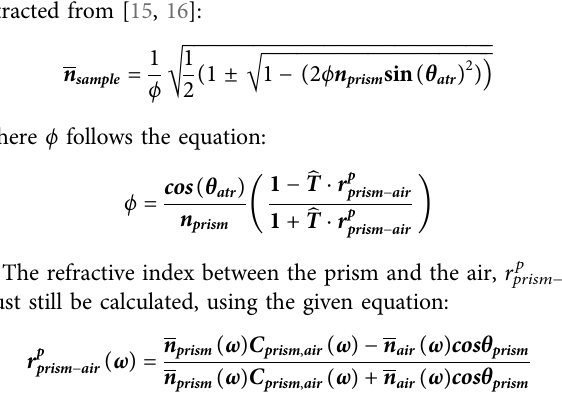
Frontiers in Physics |